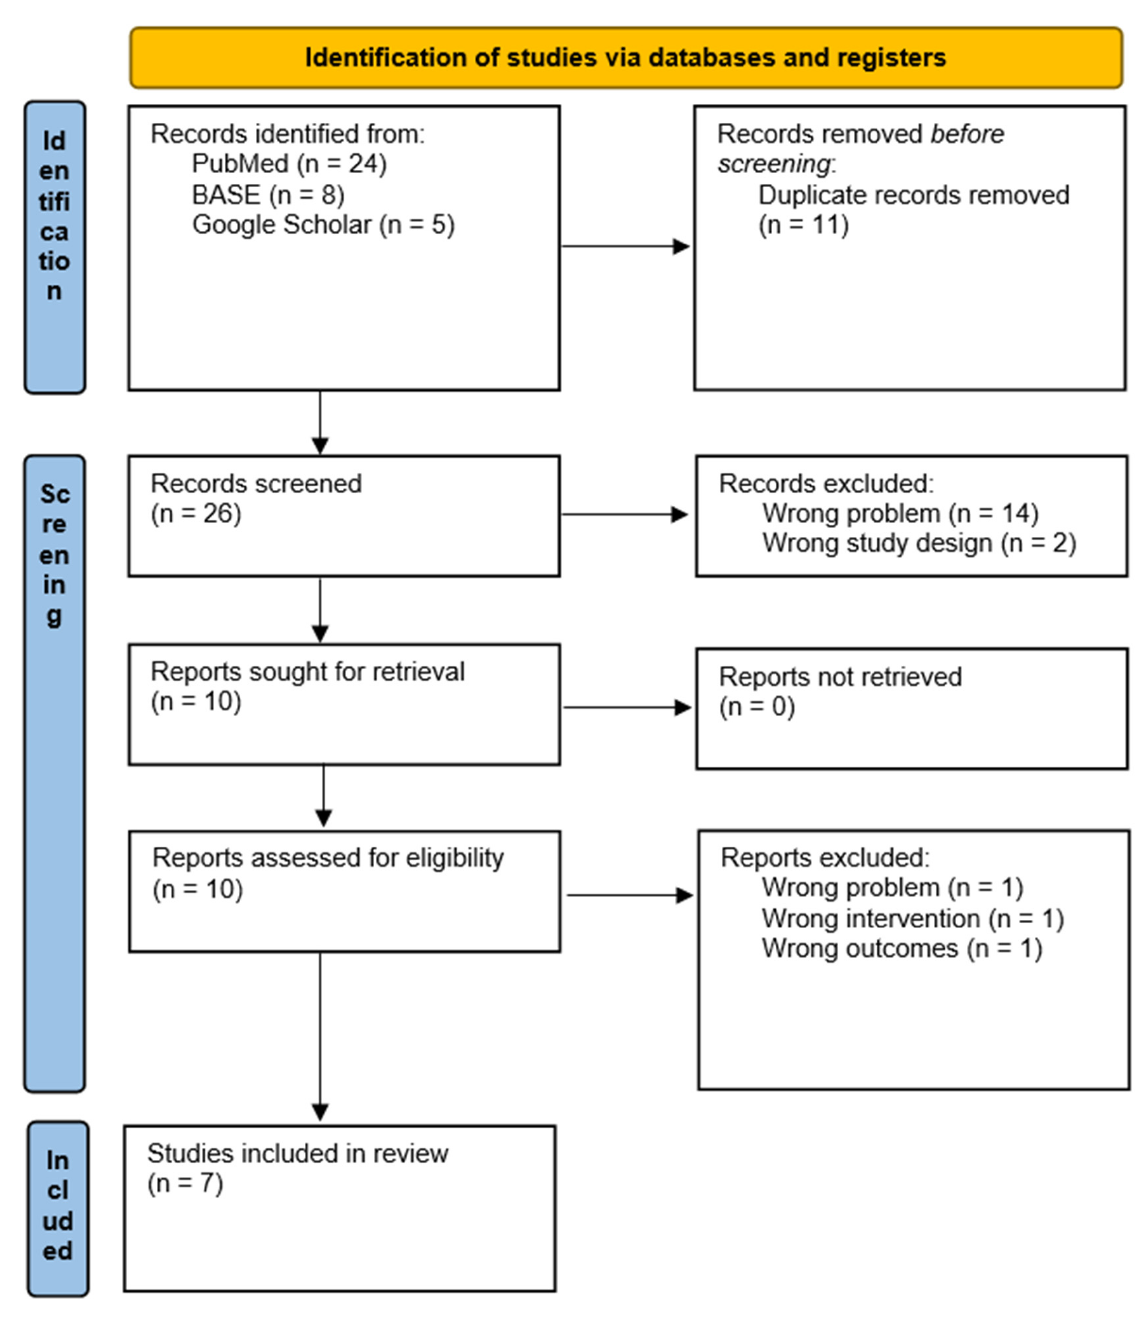
Figure 1. PRISMA flowchart used for the qualification of the studies [29]. Table 3. Summary of the studies qualified for the meta-analysis. For individual types of durability, the percentage strength in relation to the reference value obtained in the test for PMMA without nanofiller is given.